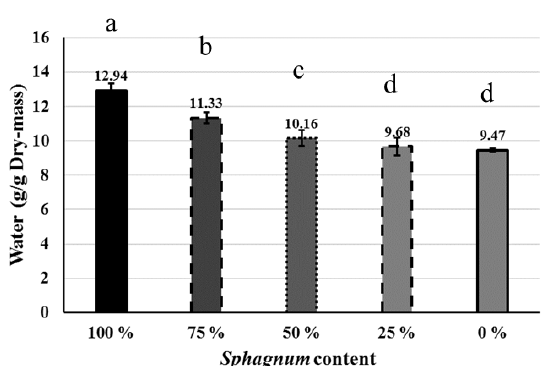
Figure 4. Water retention of sweet basil experimental mixtures ( S. fuscum dominated) after a 10-day saturation period and a 24-hour equilibration period without bottom trays. The dry matter in each pot was standardised to 70 g, resulting in bulk densities of ~ 72 kg m − 3 . Letters indicate significant differences between groups (p < 0.05). Bars denote ± SD. n = 16.